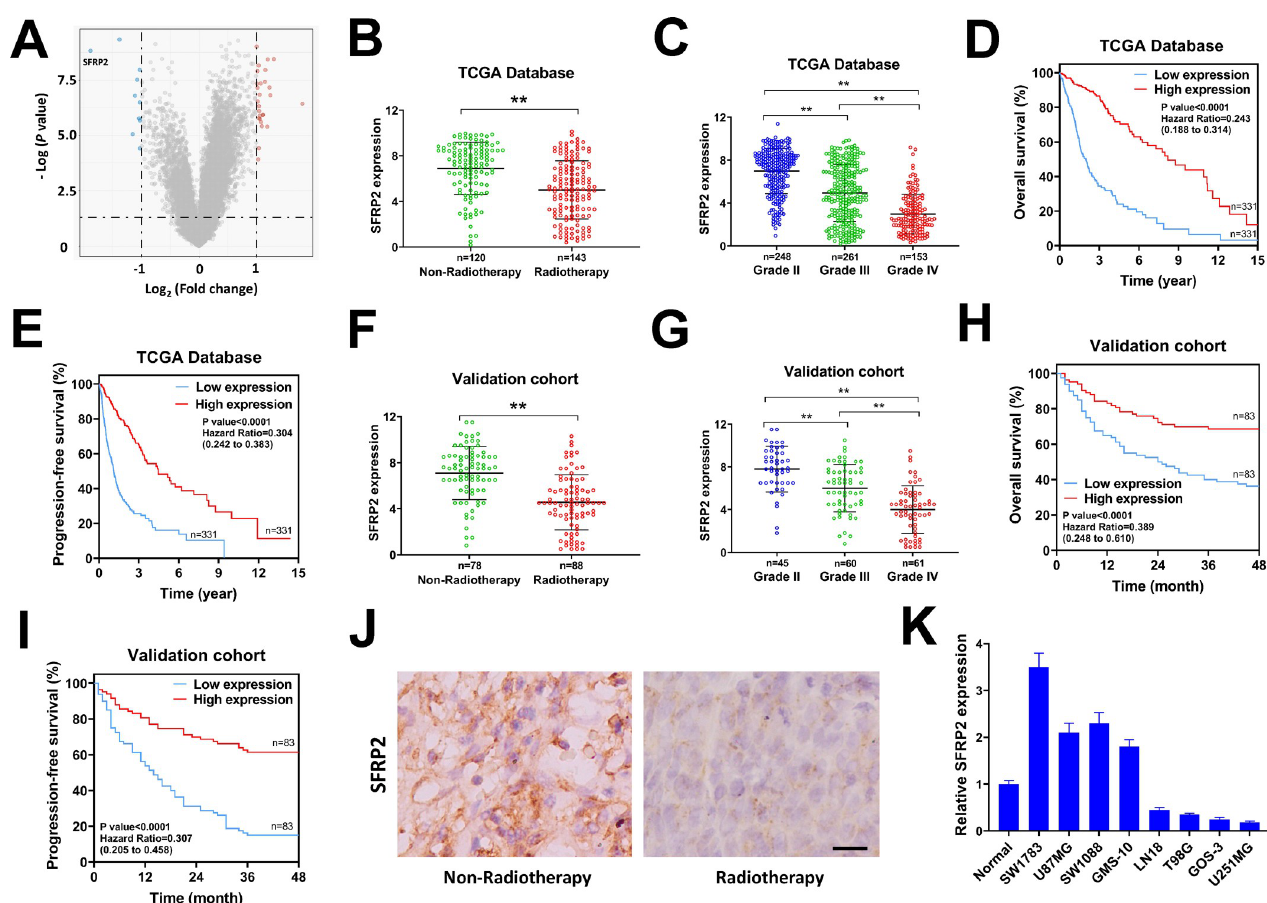
Fig 1. SFRP2 is downregulated in radiotherapy treated glioma patients and predicted poor prognosis. A, the differentially expressed mRNAs in radiotherapy-treated glioma patients versus non-radiotherapy treated glioma patients in TCGA were depicted in the volcano plots. B, SFRP2 expression in radiotherapy-treated glioma patients and non-radiotherapy treated glioma patients in TCGA. C, SFRP2 expression in WHO grade II, III and IV glioma patients in TCGA. D, overall survival of glioma patients according to SFRP2 expression in TCGA. E, progression-free survival of glioma patients according to SFRP2 expression in TCGA. F, SFRP2 expression in radiotherapy-treated glioma patients and non-radiotherapy treated glioma patients in the validated cohort of our study. G, SFRP2 expression in WHO grade II, III and IV glioma patients in the validated cohort of our study. H, overall survival of glioma patients according to SFRP2 expression in the validated cohort of our study. I, progression-free survival of glioma patients according to SFRP2 expression in the validated cohort of our study. J, IHC staining of SFRP2 in radiotherapy-treated glioma tissue and non-radiotherapy treated glioma tissue. K, SFRP2 expression in glioma cell lines or normal glia tissue was evaluated by qRT-PCR. �� P < 0.001.